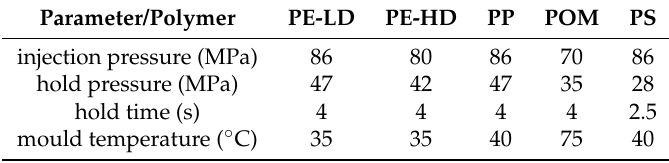
Table 4. Constant parameters of the injection moulding process.